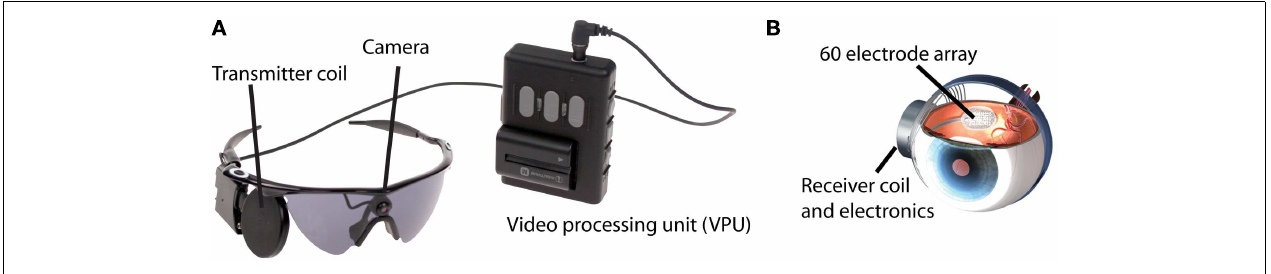
(VPU), and a transmitter coil. (B) The internal portion, consisting of a receiver coil connected with a bus to a 60 electrode epiretinal